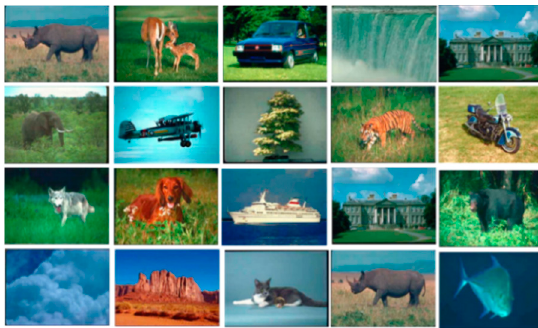
Figure 14. Example images from the Corel-10k dataset.